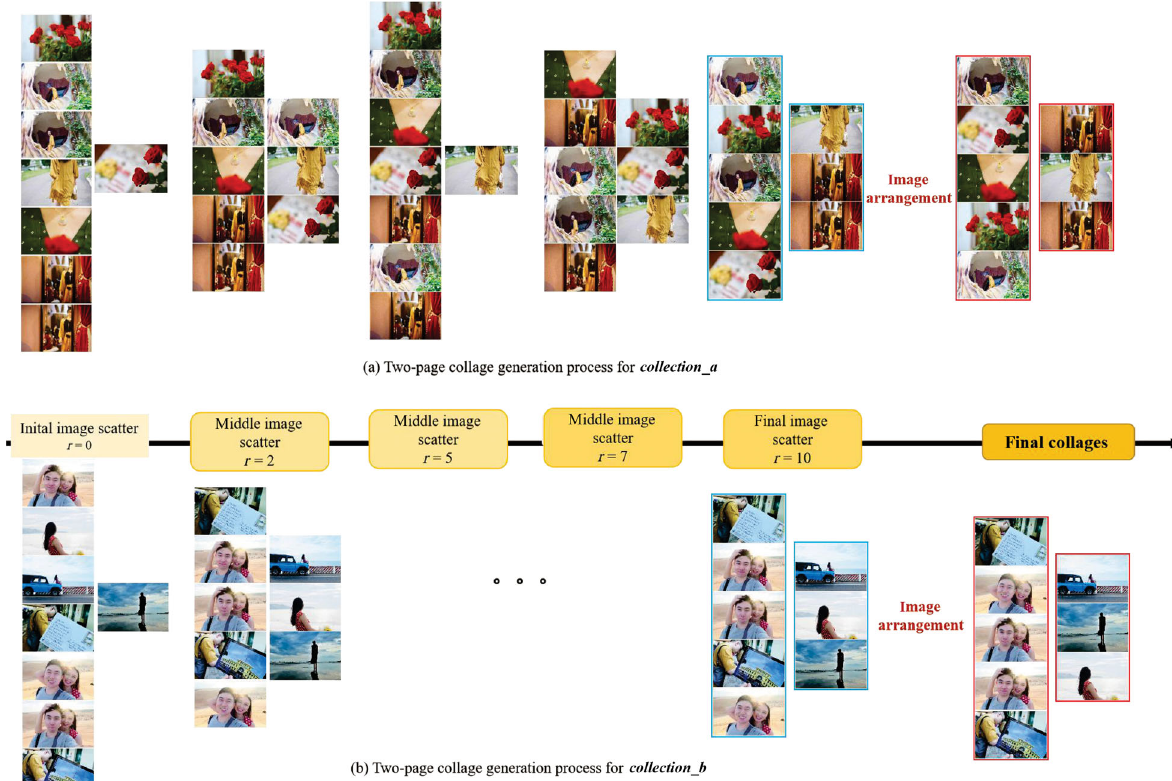
Fig. 7 Pipeline of two-page collage generation. The entire generation follows the timeline, yellow blocks represent the iteration number, and collages nearby are the corresponding image scatter result. The image scatter result is surrounded by blue boxes. Then, the images in each page will be rearranged in accordance with the mechanism of uniqueness value computation and image similarity matching. The final collage result is labeled by red